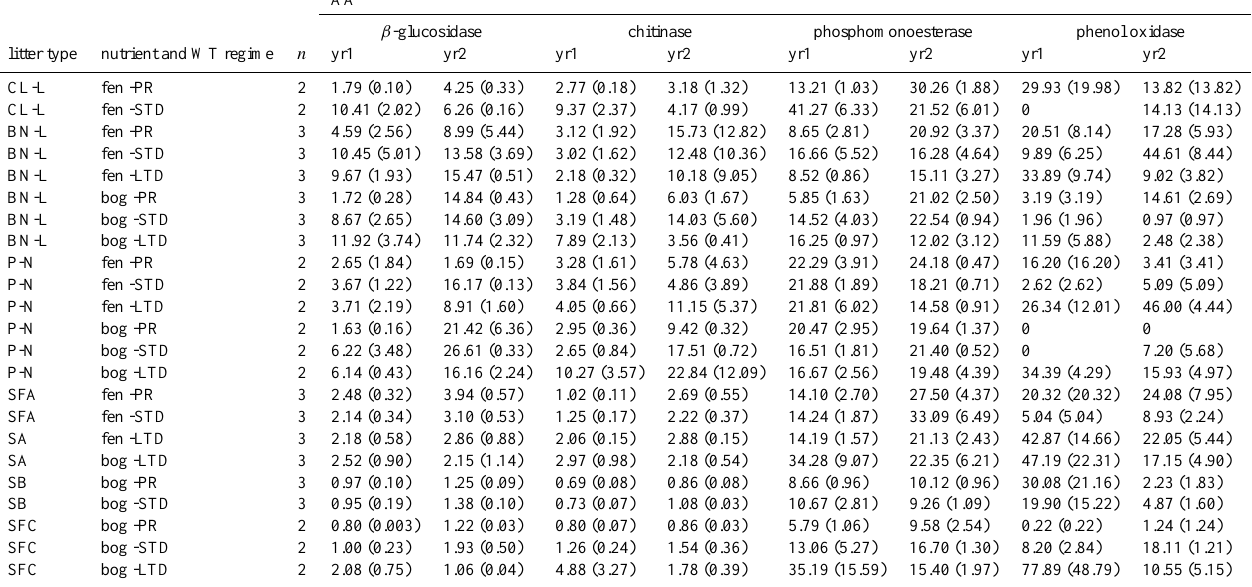
Table A1 Enzyme activity (µmol of substrate converted per minute and per g of litter dry weight), mass loss (%) and pH, mean values per litter type and plot of different nutrient and/or water table regimes with standard error of mean in parenthesis. The standard error indicates variation in enzyme activities and mass loss within a plot.